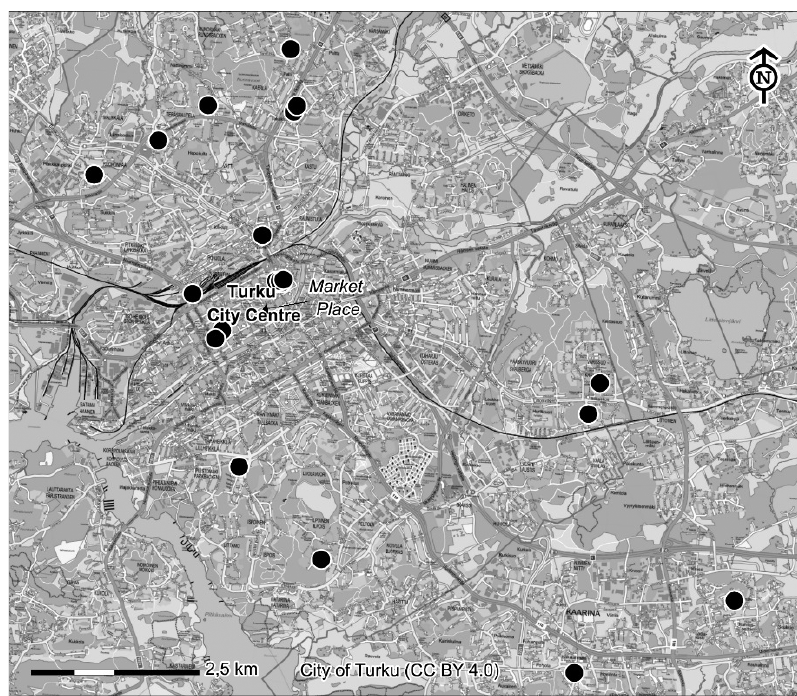
Figure 2. The focus-group participants’ place of residence with respect to the city centre.